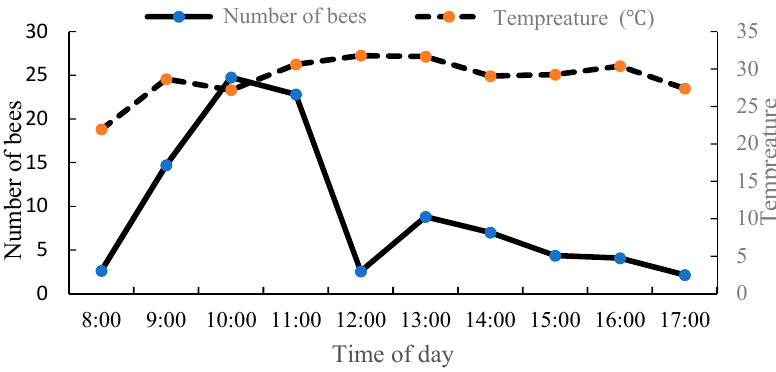
Figure 3. Diurnal activity of A. mellifera on the oil tree peony ‘Feng Dan’.